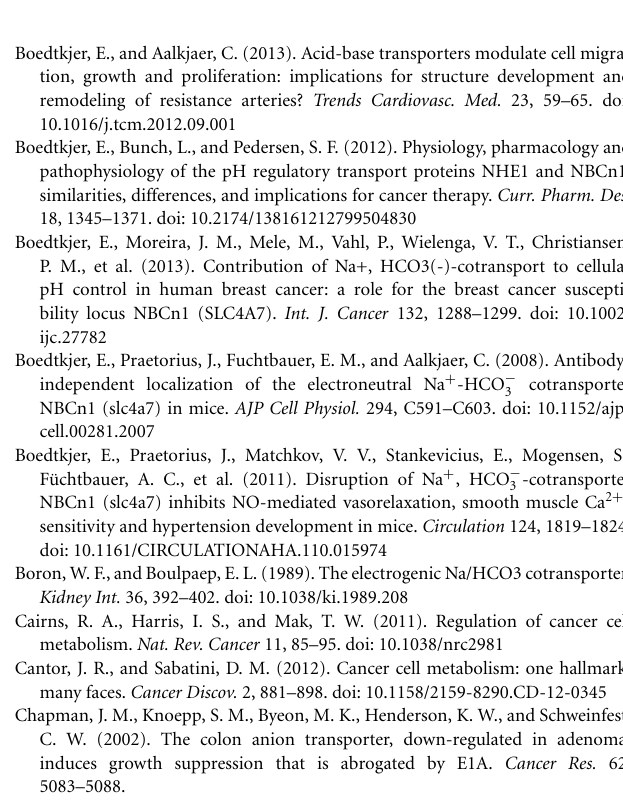
color scale represents changes of gene expression: up-regulation (red color), down-regulation (green) or no change (black). Data is expressed as log2 transformed RNA-seq RSEM counts normalized to log2 transformed mean of the